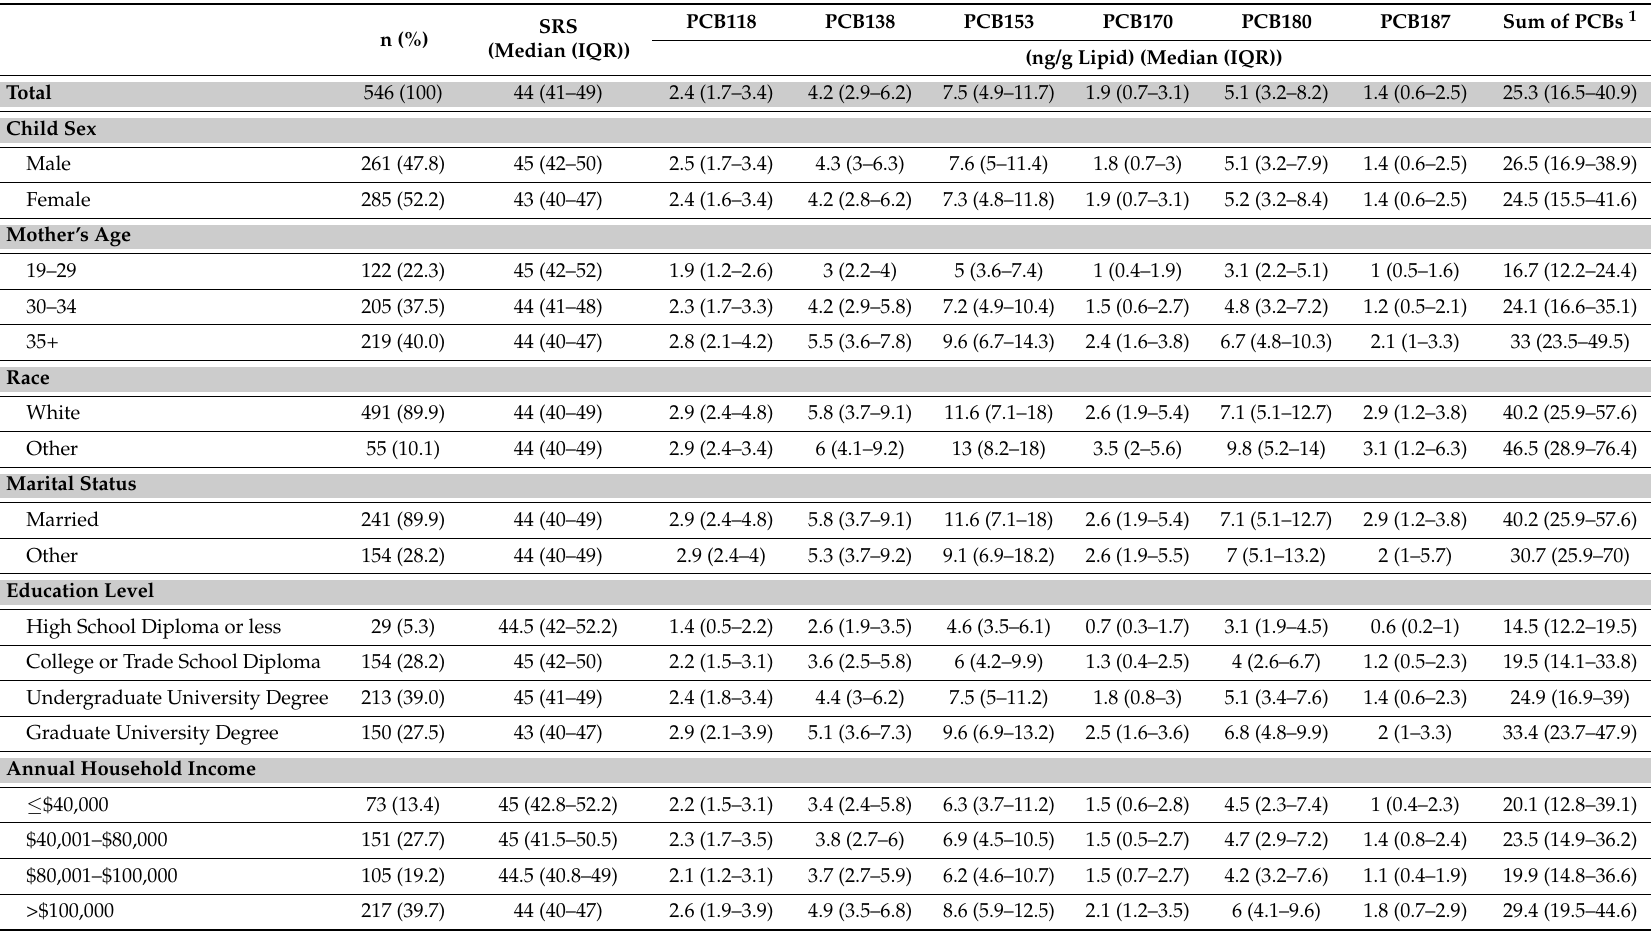
Table 3. Sociodemographic characteristics of MIREC study participants, Canada, 2008–2011 ( n =